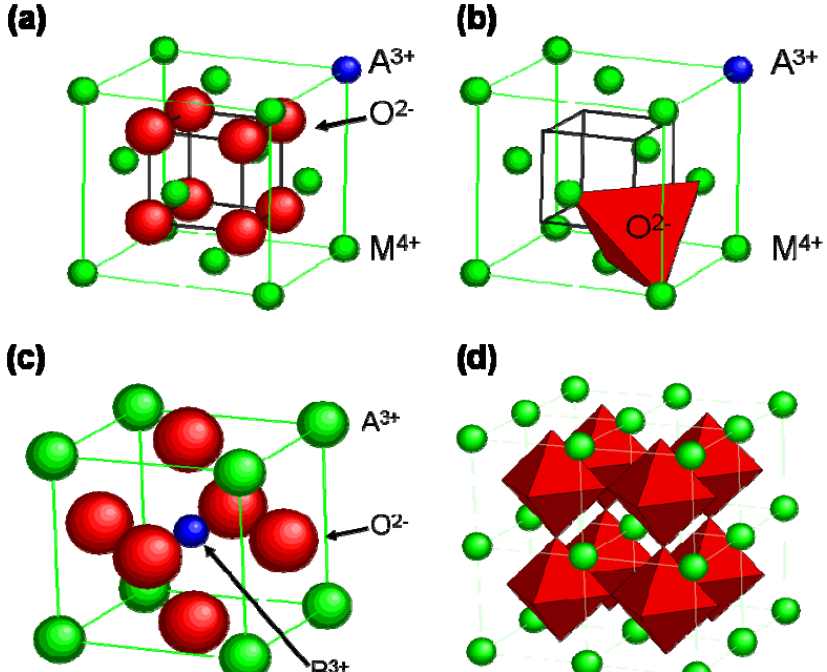
Figure 5. Sketches of the crystallographic structure of the most important oxide ionic conductors. Doped oxide fluorite structure with (a) the host metallic cation (M) in green, the aliovalent dopant (A) in blue and the oxygen (O) in red; (b) tetrahedral site for the (c) unit cell and (d) corner-shared BO oxide ion. Ideal perovskite type structure ABO 3 6/2 octahedra in a cubic array with A cation at the body center